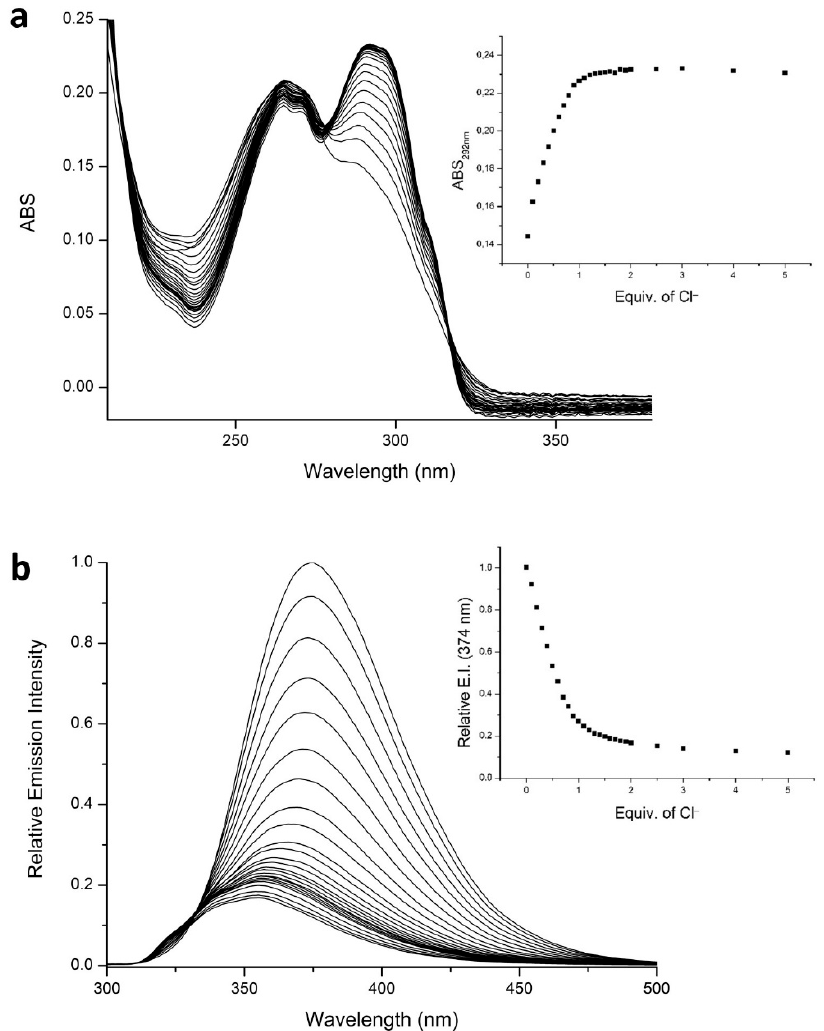
Figure 2. UV-Vis absorption ( a ) and fluorescence titration ( b ) of [ZnL] 2+ species (1.35 × 10 − 5 mol dm − 3 ; λ ex = 278 nm) with Bu 4 NCl in CH 3 CN solution at 298 ± 0.1 K. Inset: trend of the absorption at 292 nm and of the emission intensity at 374 nm as a function of Cl − added.